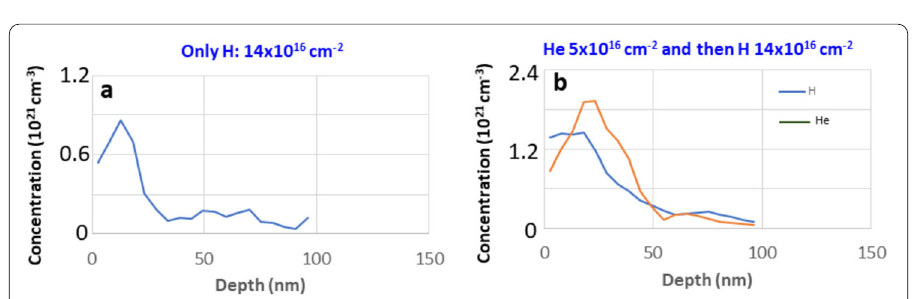
Figure 3 ToF HIERDA depth profiles of H and He following two types of irradiation: ( a ) irradiation only with H; ( b ) irradiation with He followed by H